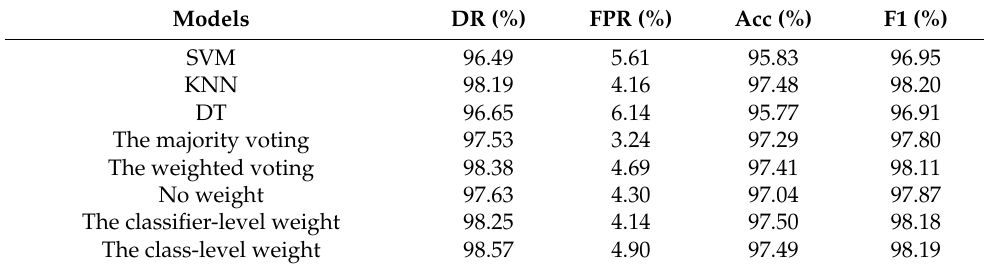
Table 8. Performance comparisons of the base learners and different voting ensemble methods with feature selection on the NSL-KDD